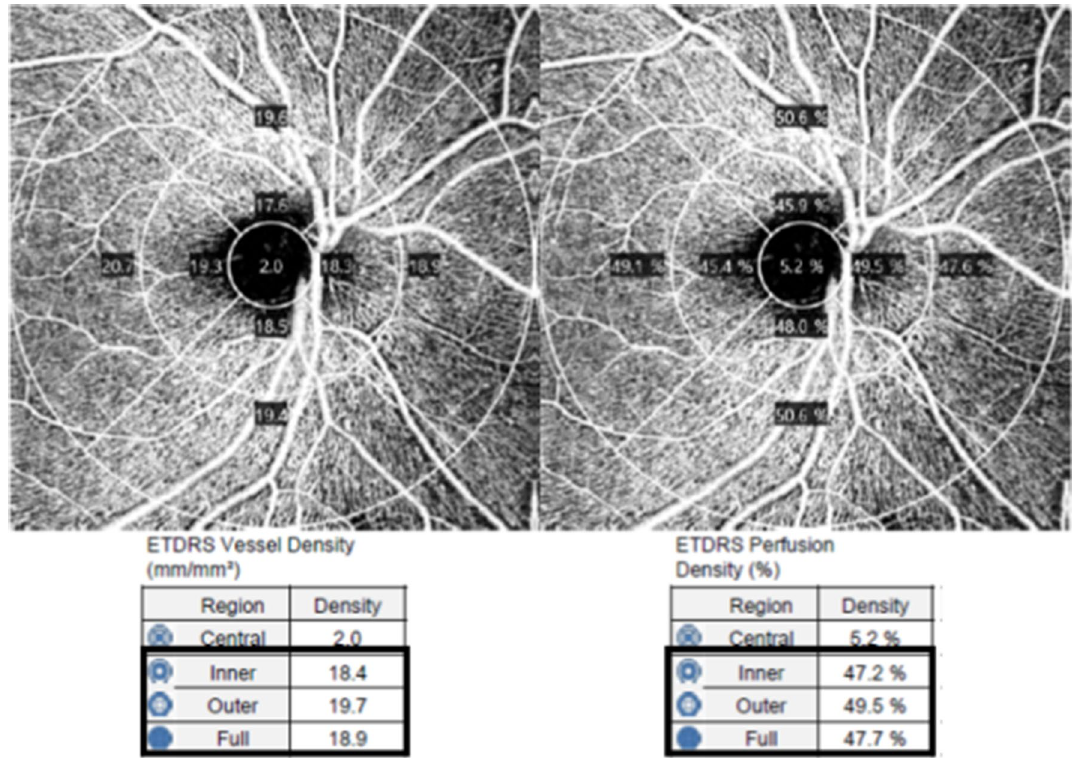
Figure 1. A representative 6 × 6 mm optical coherence tomography angiography centered on the optic disc. The en face image of the superficial capillary plexus overlaid with the Early Treatment of Diabetic Retinopathy Study grid. The black boxes show the automatic quantitative measurements for an average vessel density and perfusion density of the inner ring, outer ring, and full area.